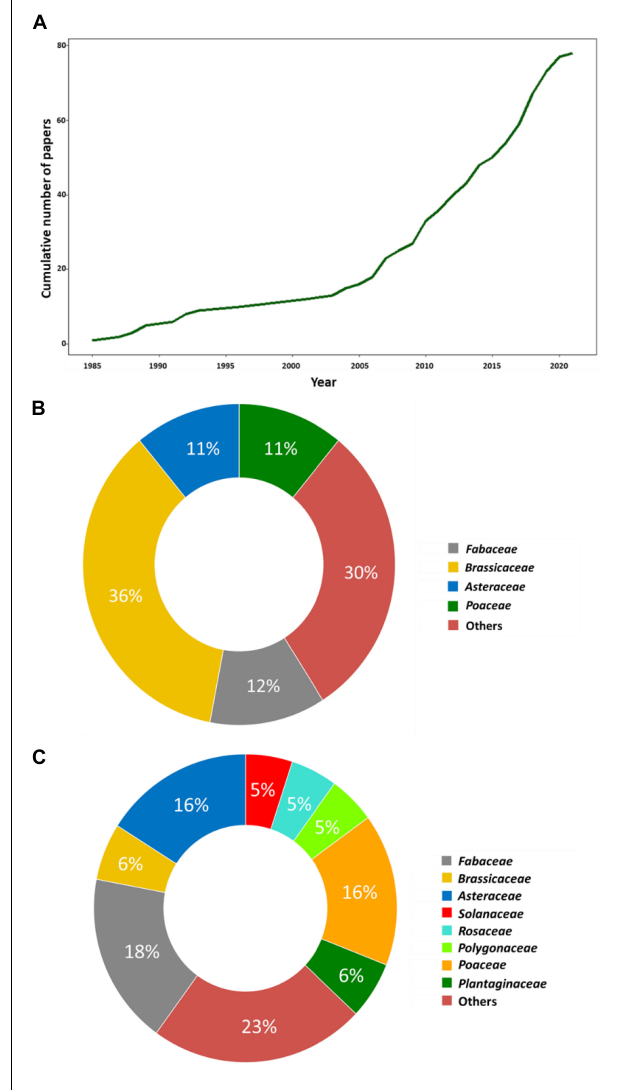
FIGURE 1 | Surveying GxG interactions within herbaceous wild species. (A) Cumulative number of papers on GxG interactions in wild plant species from 1985 to 2021. (B) Doughnut plots describing the distribution of the major botanical families used in the study of intraspecific GxG interactions. (C) Doughnut plots describing the distribution of the major botanical families used in the study of intraspecific GxG interactions upon removal of Arabidopsis thaliana